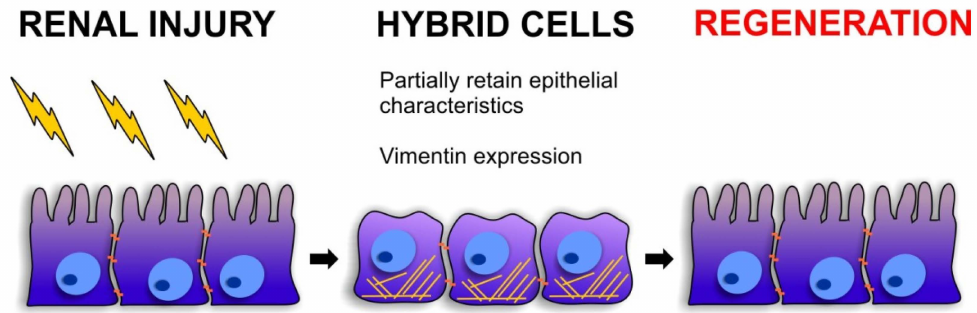
Figure 2. The role of intermediate “hybrid” cells during kidney regeneration. Following acute injury, renal epithelial cells are able to repair and recover their functionality. During this process, the renal epithelial cells undergo a process of profound plasticity in which they acquire a less epithelial phenotype and gain some mesenchymal characteristic, such as vimentin expression. These partially “reprogrammed” cells are able to proliferate and repair the